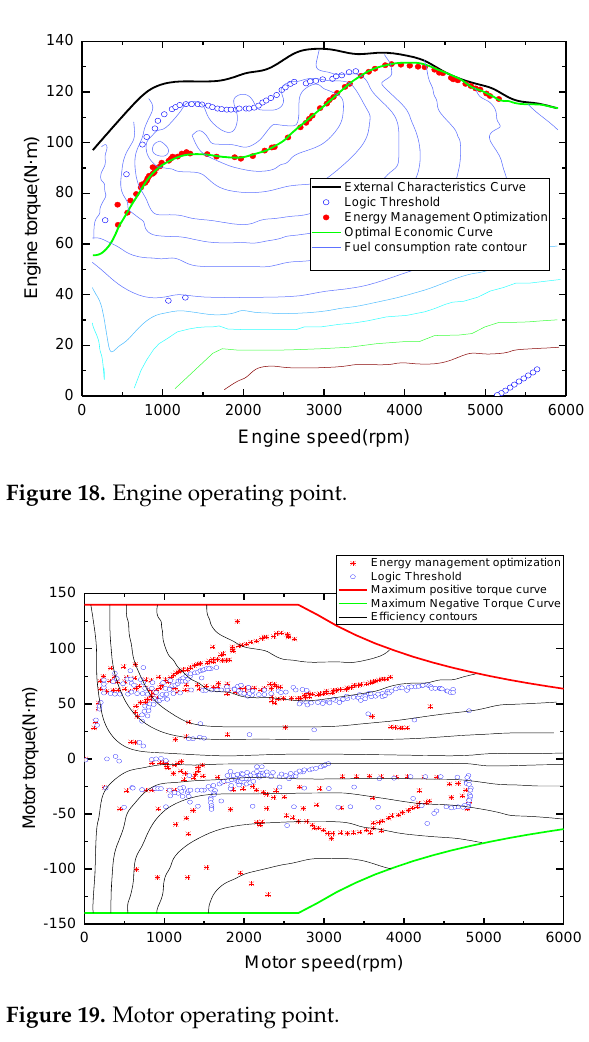
Figure 17. SOC change curve.